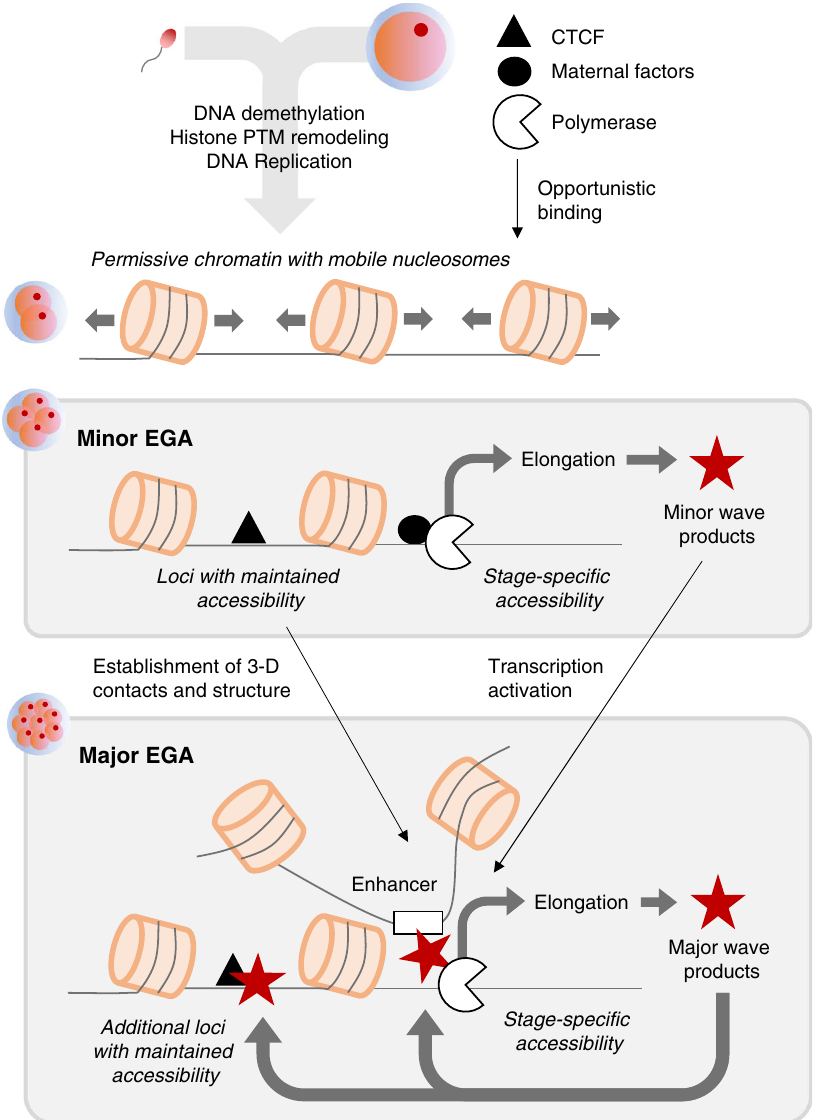
Fig. 9 Potential mechanistic model depicting events leading to major EGA. Chromatin structure is globally decondensed following fertilization, allowing opportunistic binding of maternal factors, which initiate a minor wave of transcription and begin to establish 3-D chromatin architecture. This sets the stage for major EGA, wherein maternal products, minor EGA products, and promoter-enhancer contacts mediate the fi rst major wave of gene expression